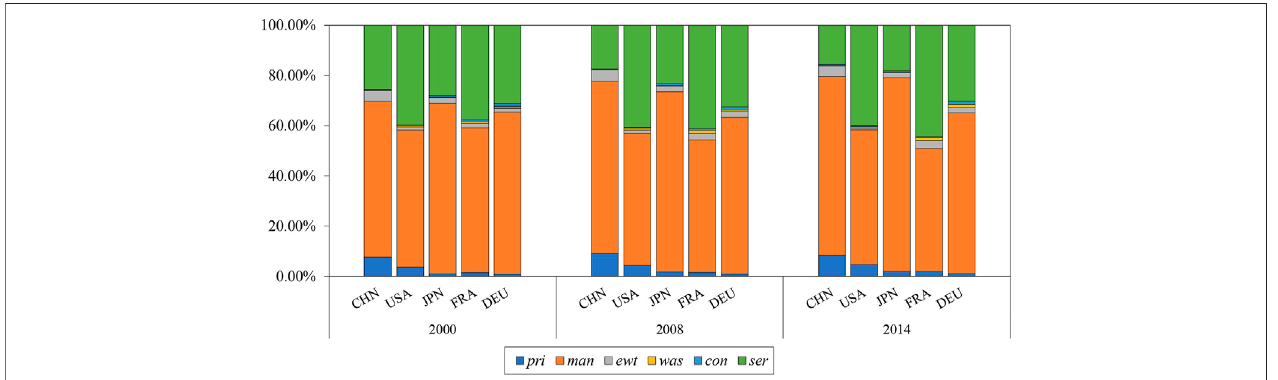
FIGURE 9 | Differences in the construction intermediate input structure between China and selected countries in the years 2000, 2008, and 2014. Note: pri represents the primary product industry including four sectors (S01-S04); man represents the manufacturing industry including 19 sectors (S05-S23); ewt represents electricity,gas, andwatercollectionsectors (S24-S25); wasrepresentsthe wastecollectionsector (S26);conrepresentsconstruction industry(S27);serrepresentsthe service industry including 29 sectors